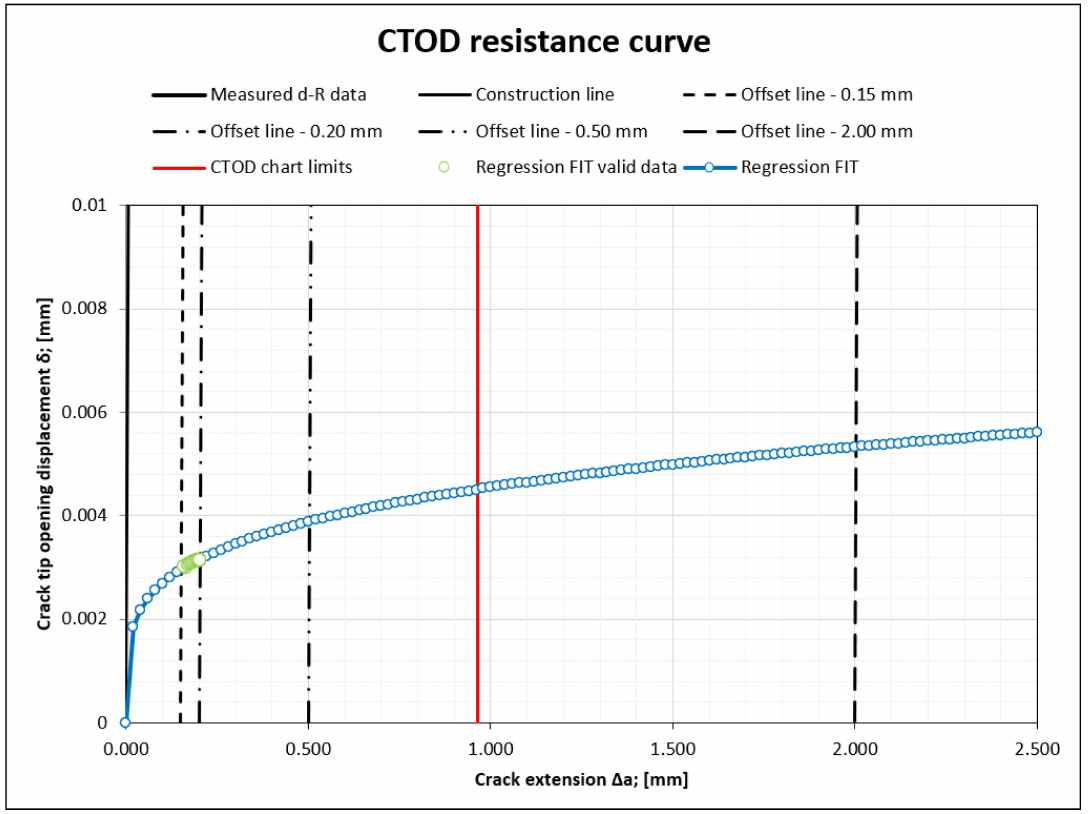
Figure 9. J integral resistance curve (sample